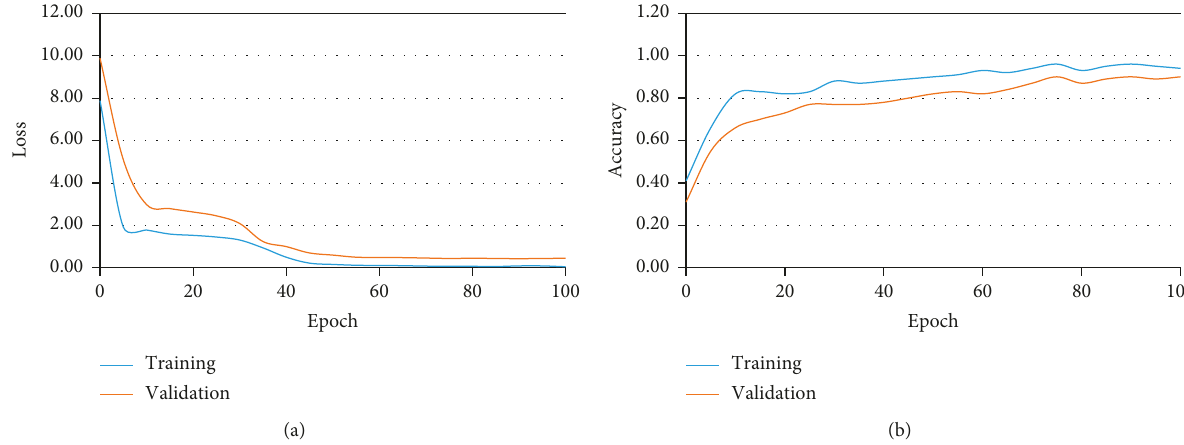
Figure 12: (a) Network loss and (b) network accuracy of the training and validation sets.